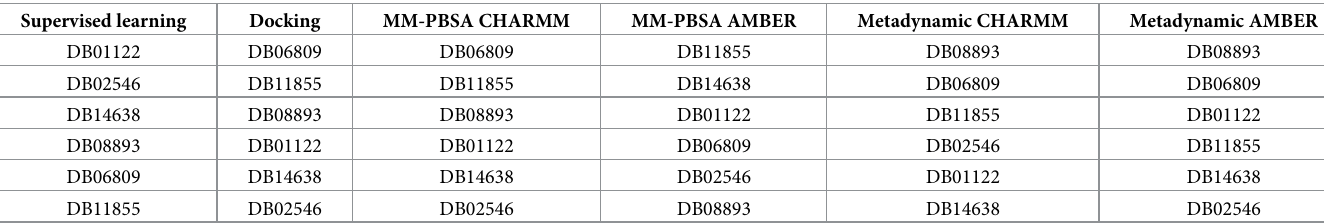
Table 5. Ranking of compounds for each step of our method. Supervised